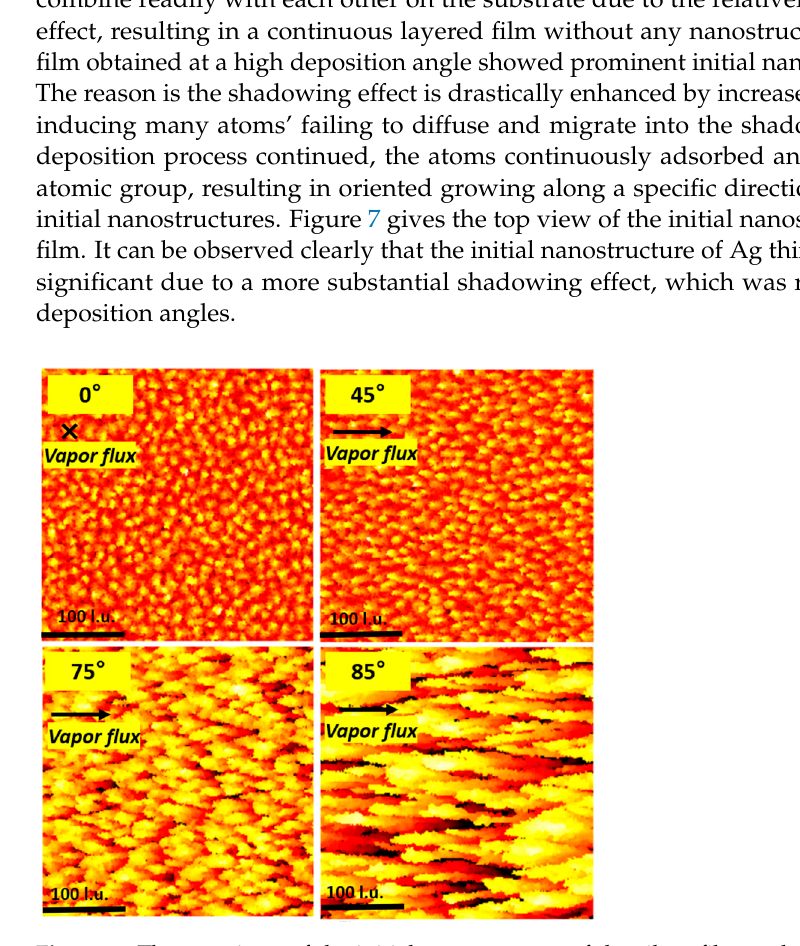
Figure 6. Film growth simulation results at the initial nanostructure growth stage (2.5 mL) under different deposition angles.